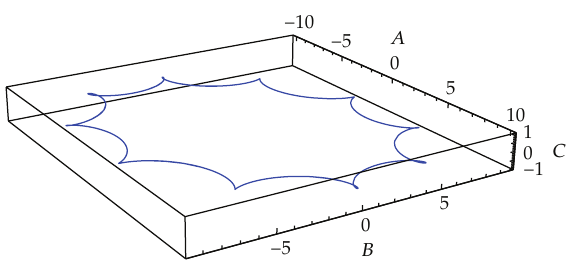
Figure 23: The spiky universe for (cid:2) 5.3 (cid:3) , n (cid:6) 10 , α (cid:6) 1.